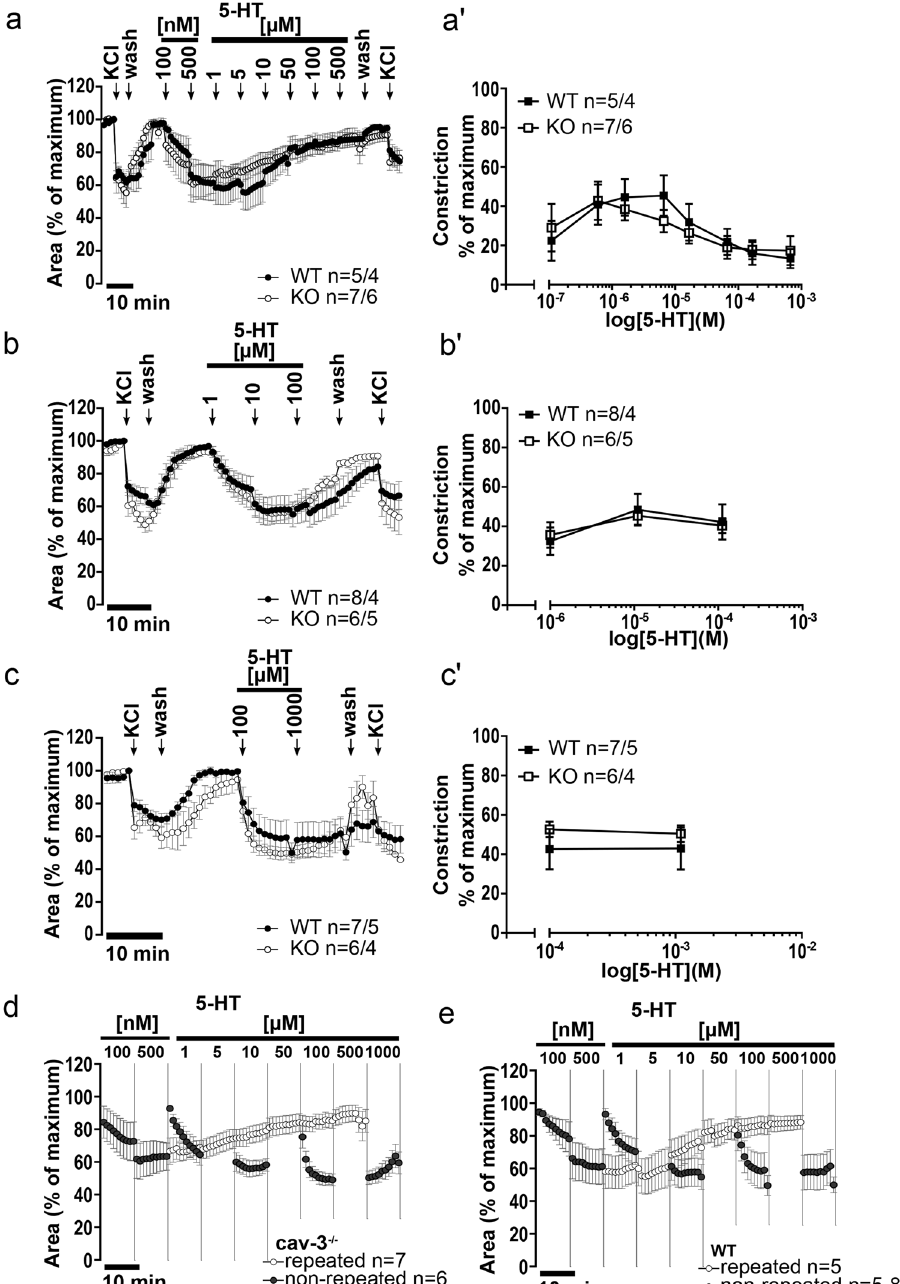
Figure 8. Bronchoconstrictor response to 5-HT of peripheral bronchi from cav-3 + / + (WT) and cav-3 − / − (KO) mice. Videomorphometric analyses of PCLS, depicted are changes in the luminal area. ( a – c ) Depicted are the 5-HT-mediated concentration-dependent changes in the luminal airway area in cav-3 + / + and cav-3 − / − mice. Data are presented as mean number of bronchi (n)/number of animals ± SEM. As a viability control, 60 mM of KCl was applied. The pre-stimulus value was set as 100%. (a’–c’) Concentration-dependent responses are shown as maximum reduction in the luminal area of mouse peripheral airways after administration of cumulative 5-HT concentrations. When data were analyzed with the Student’s unpaired t-test, at neither 5-HT application mode, a significant difference between the constrictor response from cav-3 + / + and cav-3 − / − mice was observed. ( d , e ) Comparison of the response to 5-HT after repetitive or non-repetitive stimulation in cav-3 − / − ( d ) and cav- 3 + / + ( e ) mice. The intrapulmonary bronchi show a decrease of the bronchoconstriction mediated by 5-HT after repeated 5-HT application. All data are presented as mean number of bronchi (n)/number of animals ±